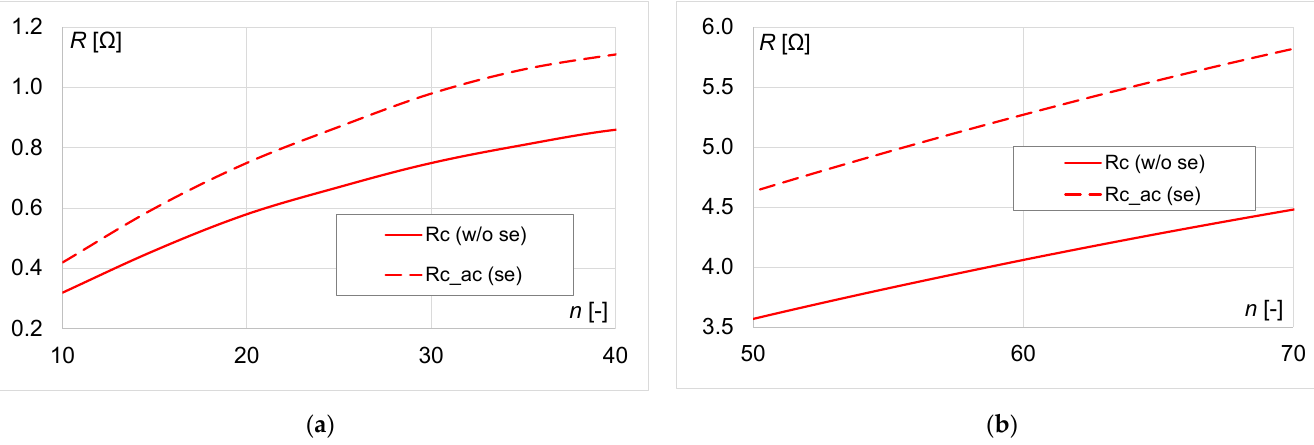
Figure 7. Coil resistance with skin effect at 1 MHz and without skin effect for ( a ) small coil; ( b ) large coil. Maximum η values were compared, depending on n and h, for cases with and without skin effect, as seen in Table 6. Increasing the number of turns and/or the radius of the coil increases the efficiency of the system. An increase in h causes a decrease in system efficiency for the same coil size. Higher η was obtained for the case without the skin effect. The results from numerical and analytical methods were compared. For each case, absolute error was calculated, which did not exceed 0.45%. It proved that the results were consistent. The greatest influence of the skin effect on the efficiency occurs for a small coil, regardless of the distance h , at 9% (Table